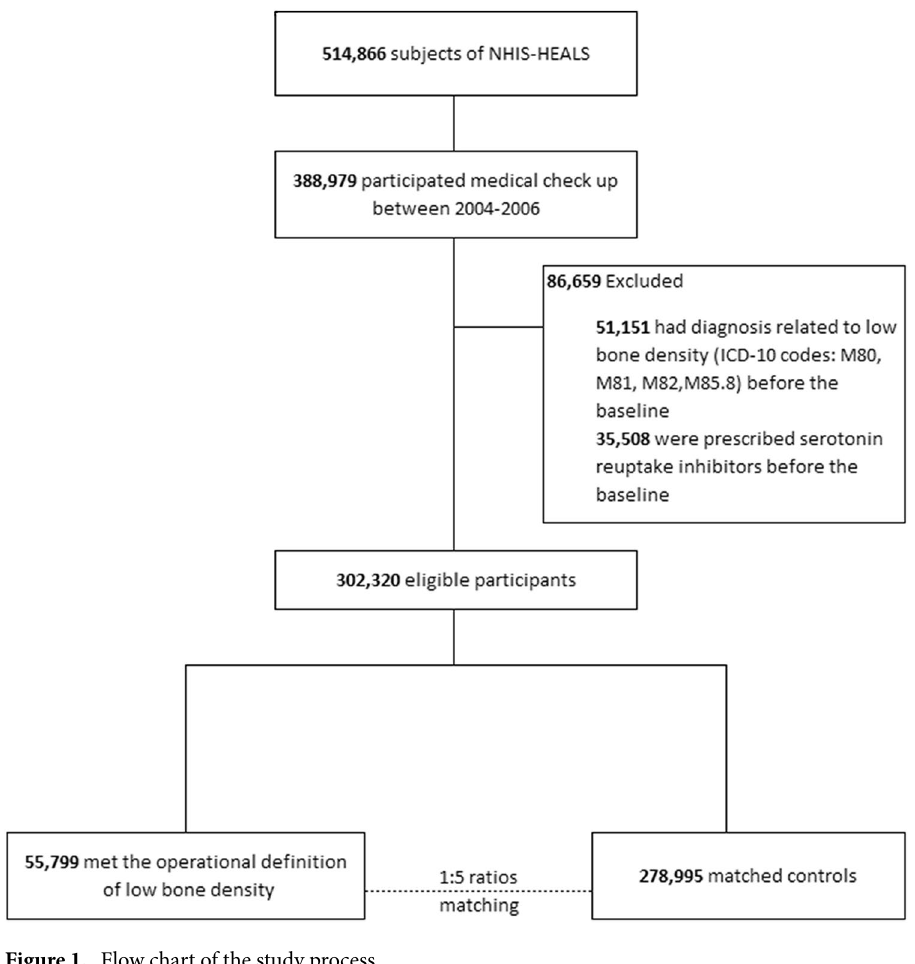
Figure 1. Flow chart of the study